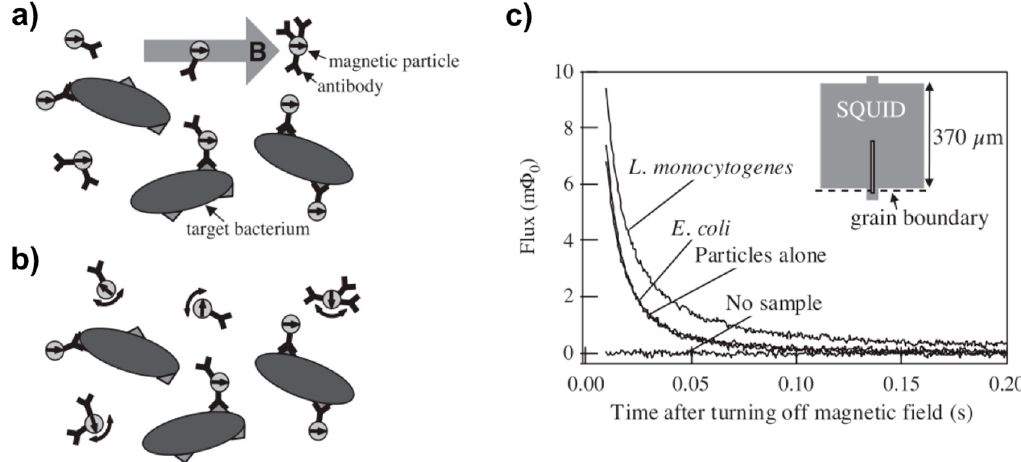
Figure 7. An example application of SQUID: ( a ) an applied magnetic field aligns the magnetic moment of MPs conjugated with an antibody, which are added into a bacteria-laden liquid suspension, ( b ) after removing the magnetic field, the unbound MPs have randomized magnetic moments due to Brownian rotation while the bound MPs slowly relax by Néel relaxation, and ( c ) magnetic decay signals including bacteria and unbound MPs. Insert: configuration of the YBCO SQUID. Reproduced with permission from [186], copyright 2004 National Academy of Sciences, U.S.A.